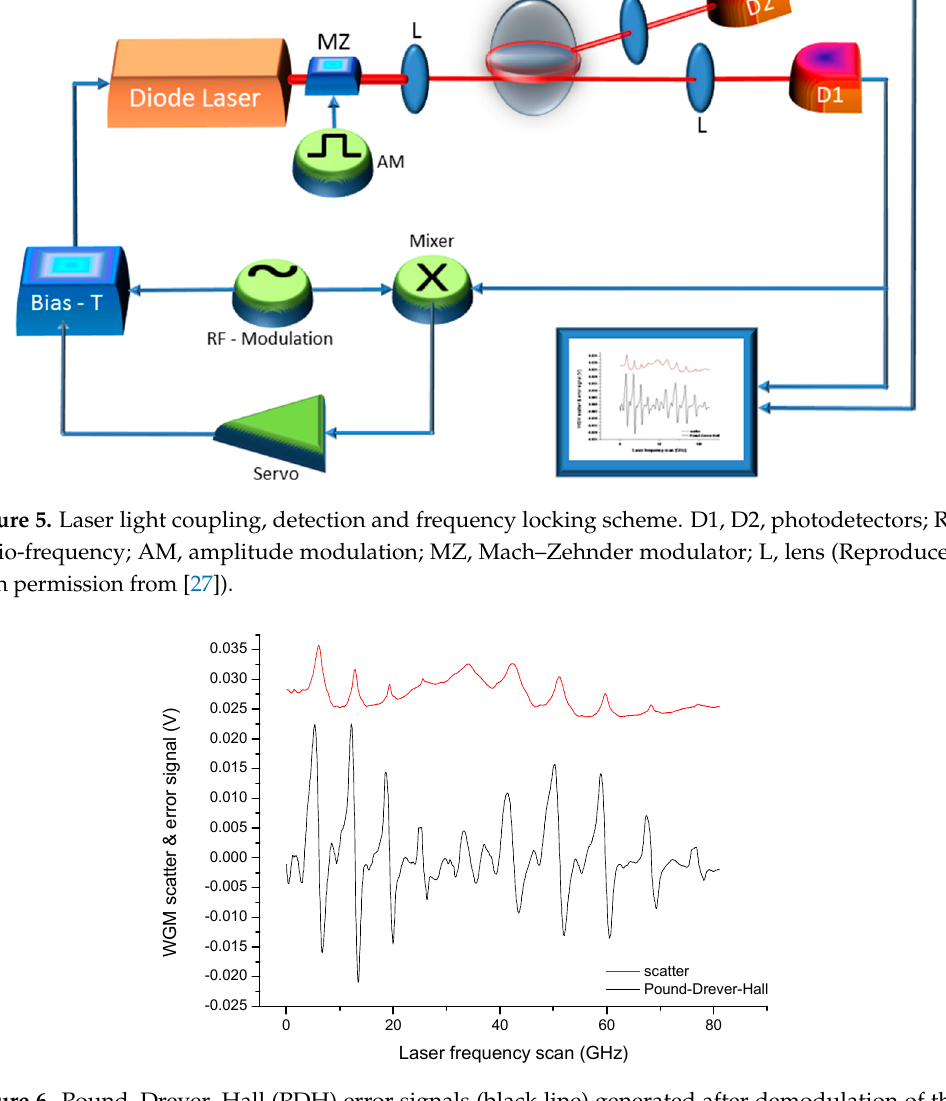
Figure 6. Pound–Drever–Hall (PDH) error signals (black line) generated after demodulation of the directly transmitted power with sidebands at about 1 GHz (paraffin oil droplet) using a diode laser emitting around 1560 nm (incident power 2 mW). The WGM scatter spectrum (red line) shows peaks that are centered exactly at the PDH signal zero crossing points (All plots are reproduced with permission plots from [27]).